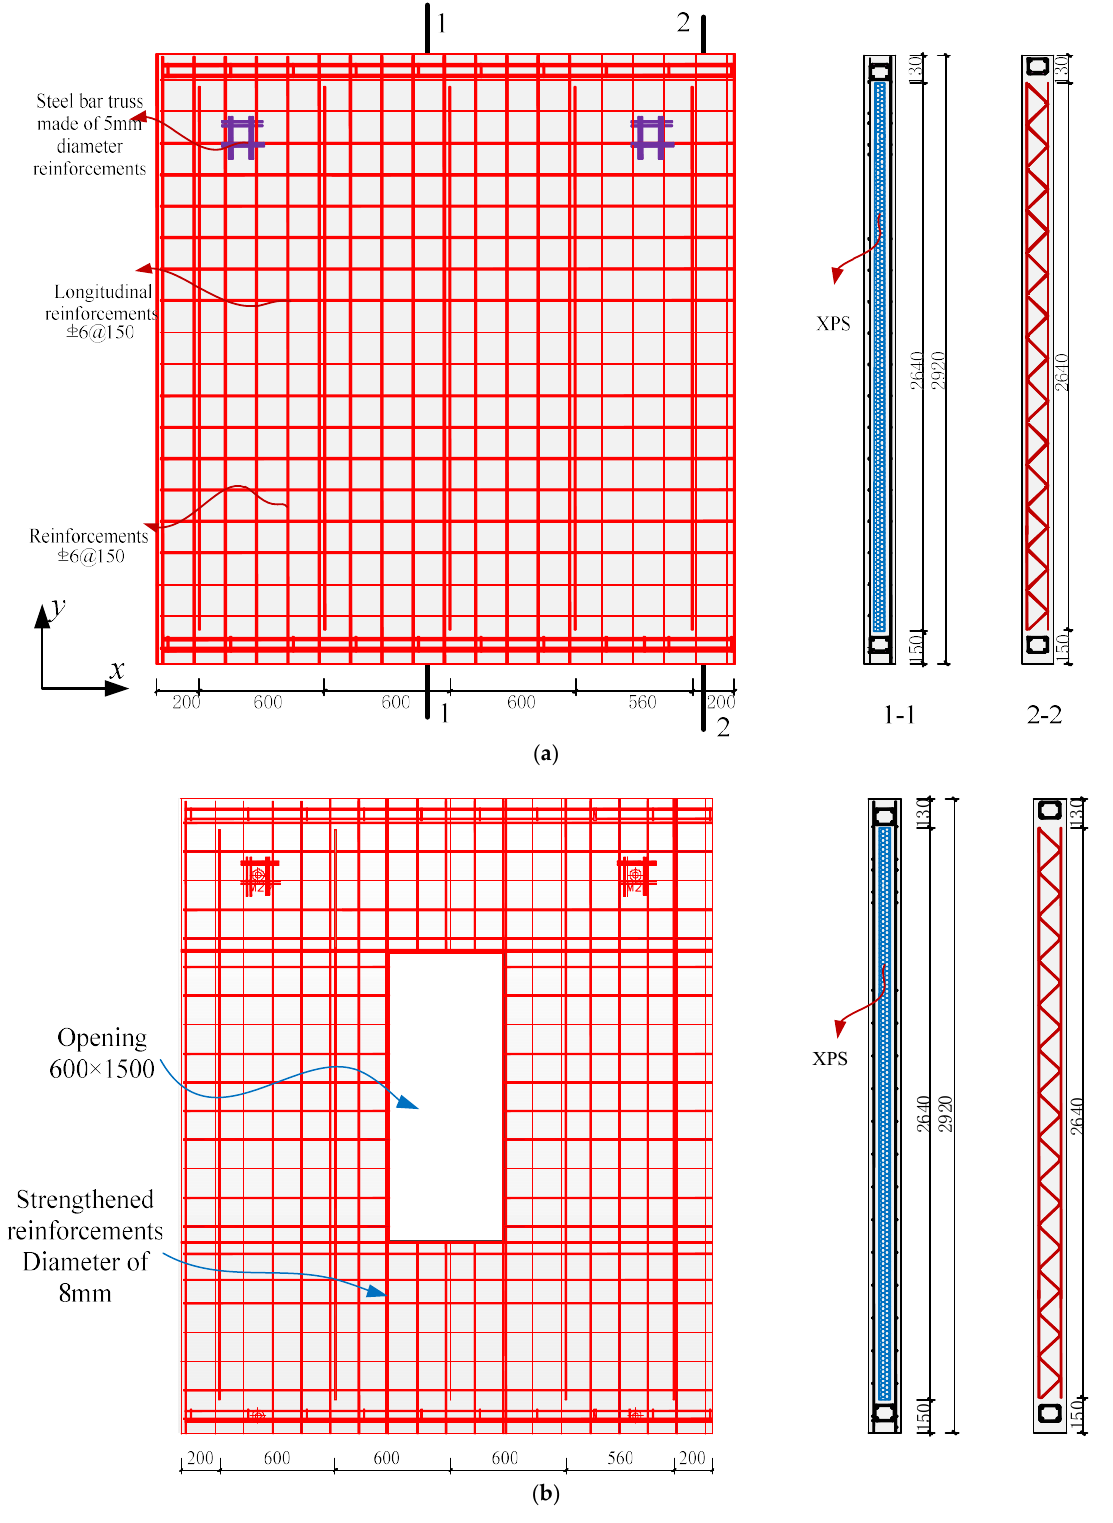
Figure 1. Details of test specimens. ( a ) Specimens WP and WN. ( b ) Specimens WPO and